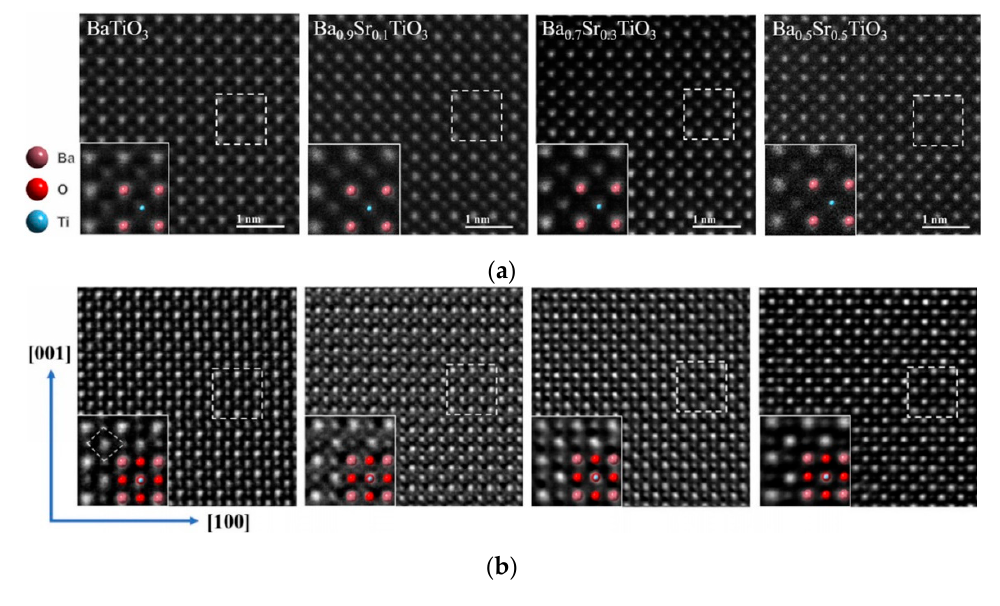
Figure 21. ( a ) iDPC-STEM image of the LSMO layer in the virgin state; ( b ) is the enlarged image of the green box in a ). Reprinted/adapted with permission from Ref. [118]. Copyright 2021, AIP Pub- lishing.